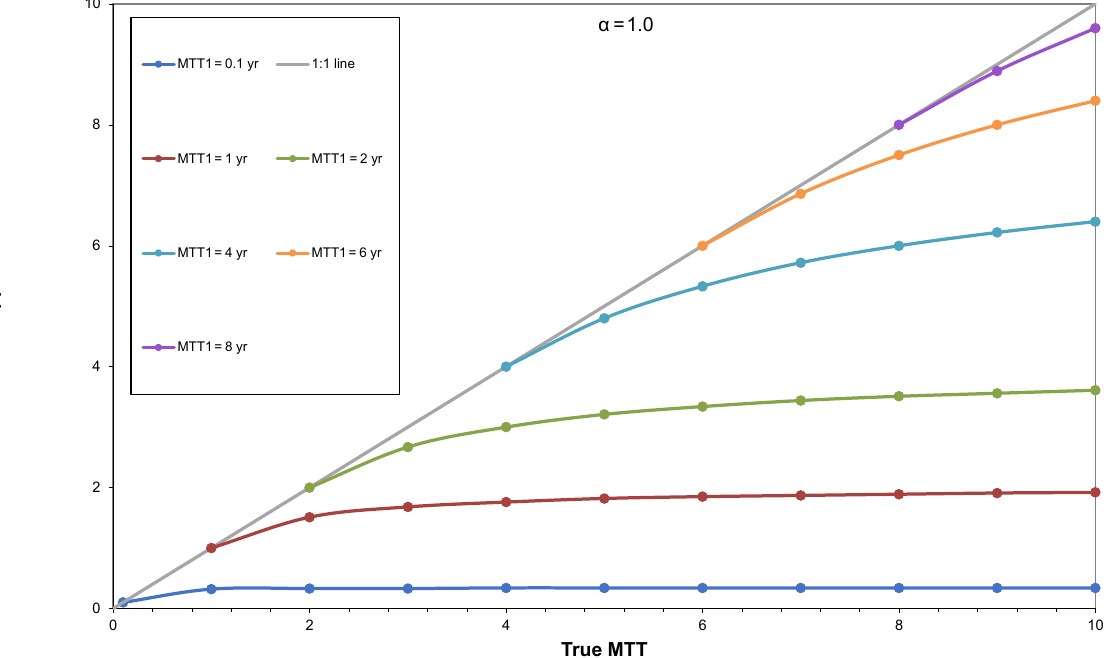
Figure 10. Aggregation effects on MTTs determined using seasonal tracer cycles for the GM with α = 1 . 0. Curves show changes as compo- nent 2 (MTT2) becomes older in 2-year steps and therefore the mixtures older in 1-year steps (shown by